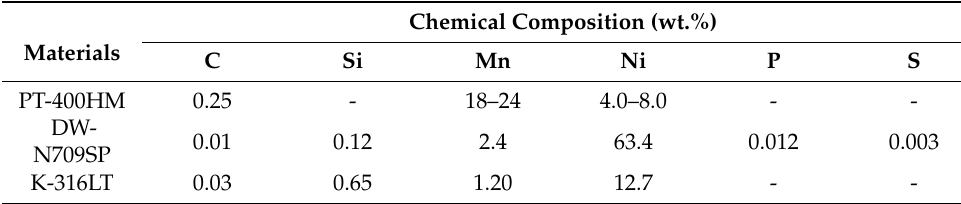
Table 4. Chemical compositions of the welding consumables.